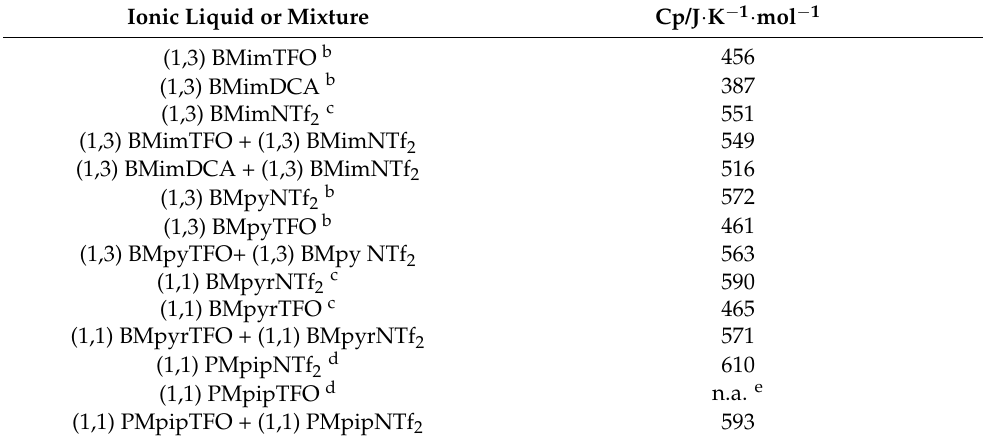
Table 4. Experimental heat capacities, Cp, for the pure ILs [10–12] and their mixtures at T = 323.15 K a . Ionic Liquid or